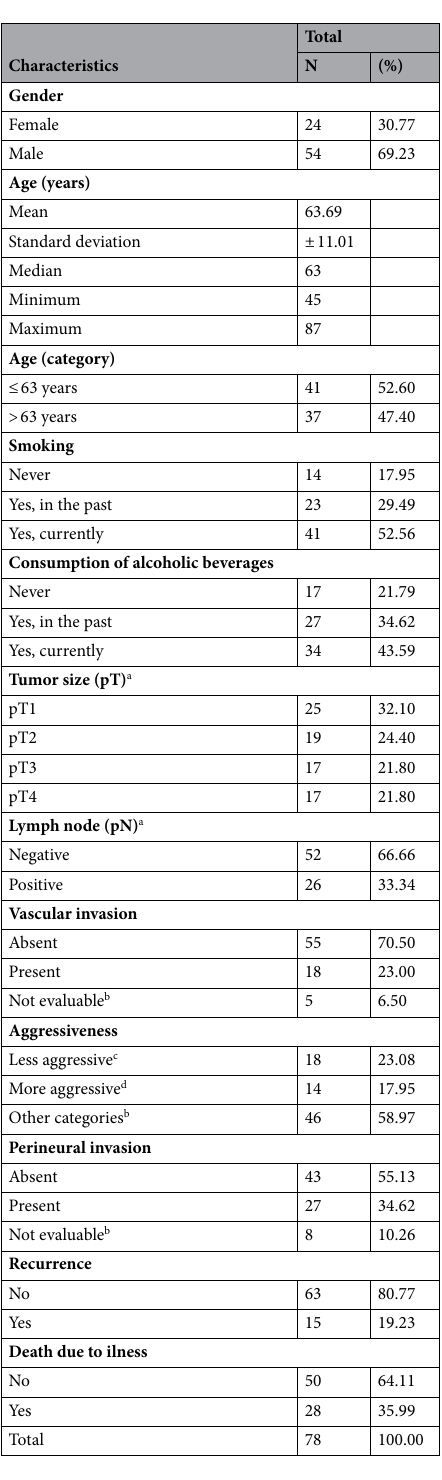
Table 4. Epidemiological, clinicopathological and prognostic characteristics of patients with oral squamous cell carcinoma. pT tumor size, pN lymph node. a TNM Classification (7th edition). b Did not enter in